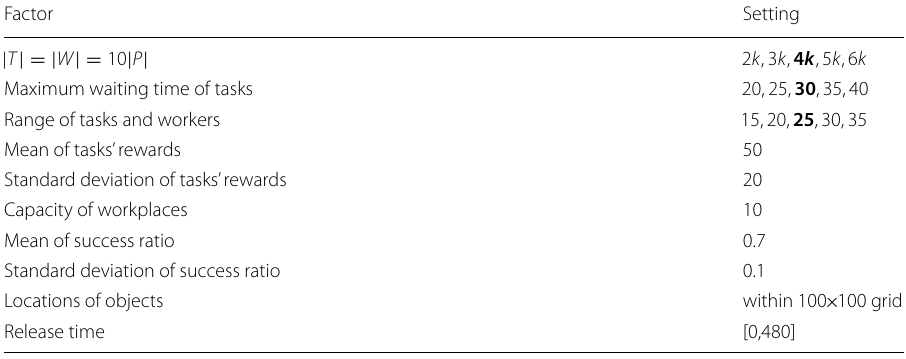
Table 2 Synthetic Dataset Factor Setting Maximum waiting time of tasks Range of tasks and workers Mean of tasks’ rewards Standard deviation of tasks’